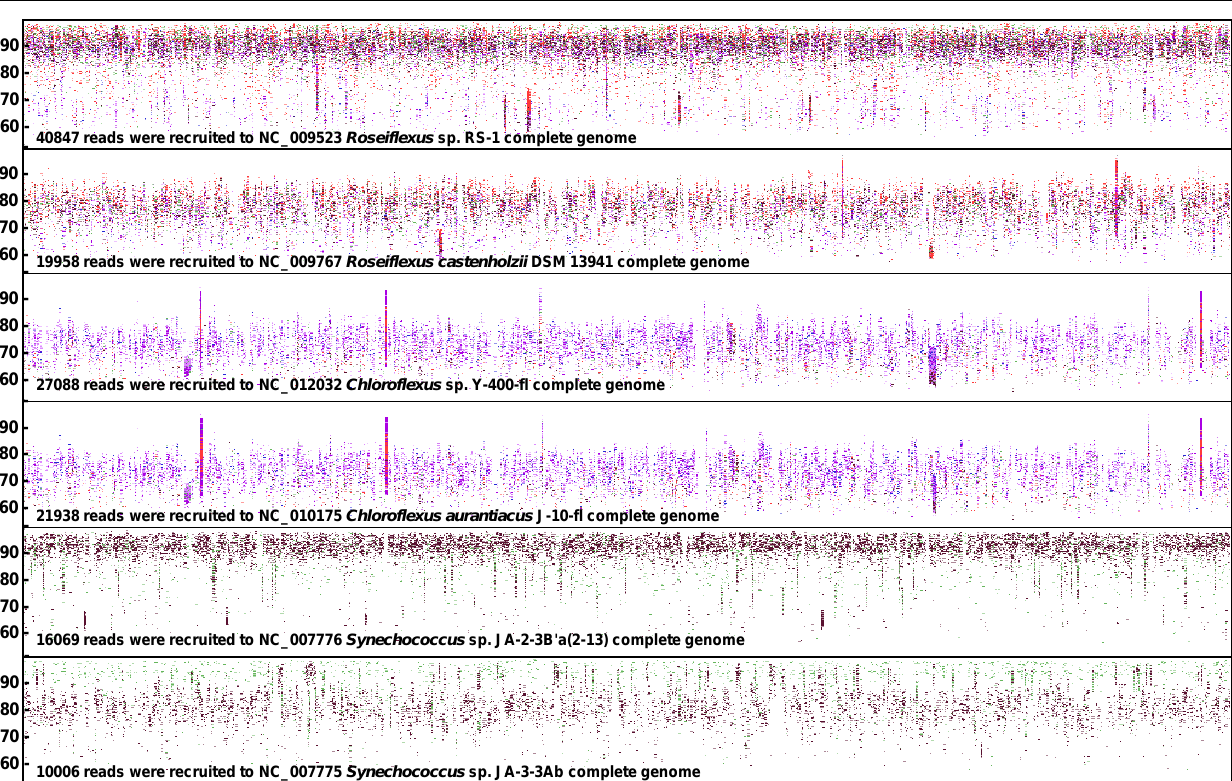
FIGUREA1 | Fragment recruitment of metagenome sequence reads from six phototrophic mat samples to the most relevant reference genomes ( y -axis = 50–100% (nt); x -axis = genome position) currently available in reference databases . Site Colors: White Creek (WC_6) = blue; Chocolate Pots (CP_7) = brown; Mushroom Spring (MS_15) = green; Fairy Geyser